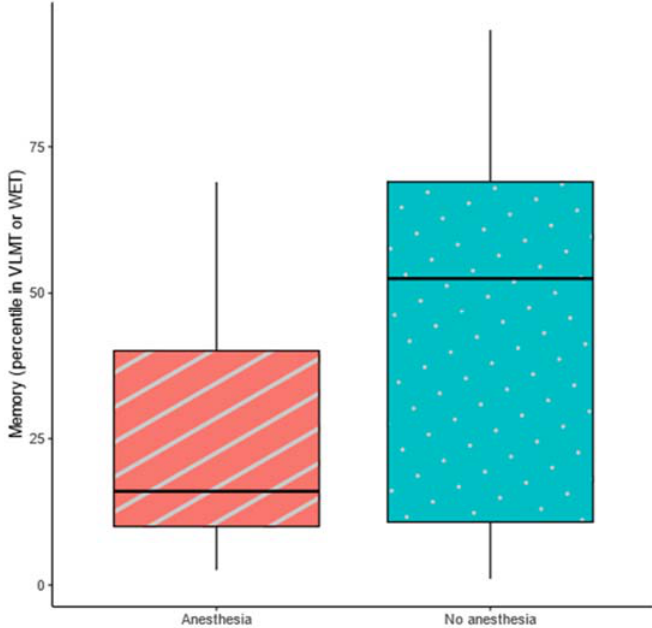
Figure 3. Boxplot of patients’ memory, as measured by VLMT or WET, compared by MRI success. Table 3. Comparisons of the groups MRI success vs. no MRI success regarding neuropsychological and behavioral variables. MRI success was used as a dichotomous grouping variable, while neu- ropsychological and behavioral variables were used as outcomes. Negative Cohen’s d s indicate lower values in the no-success group compared to the success